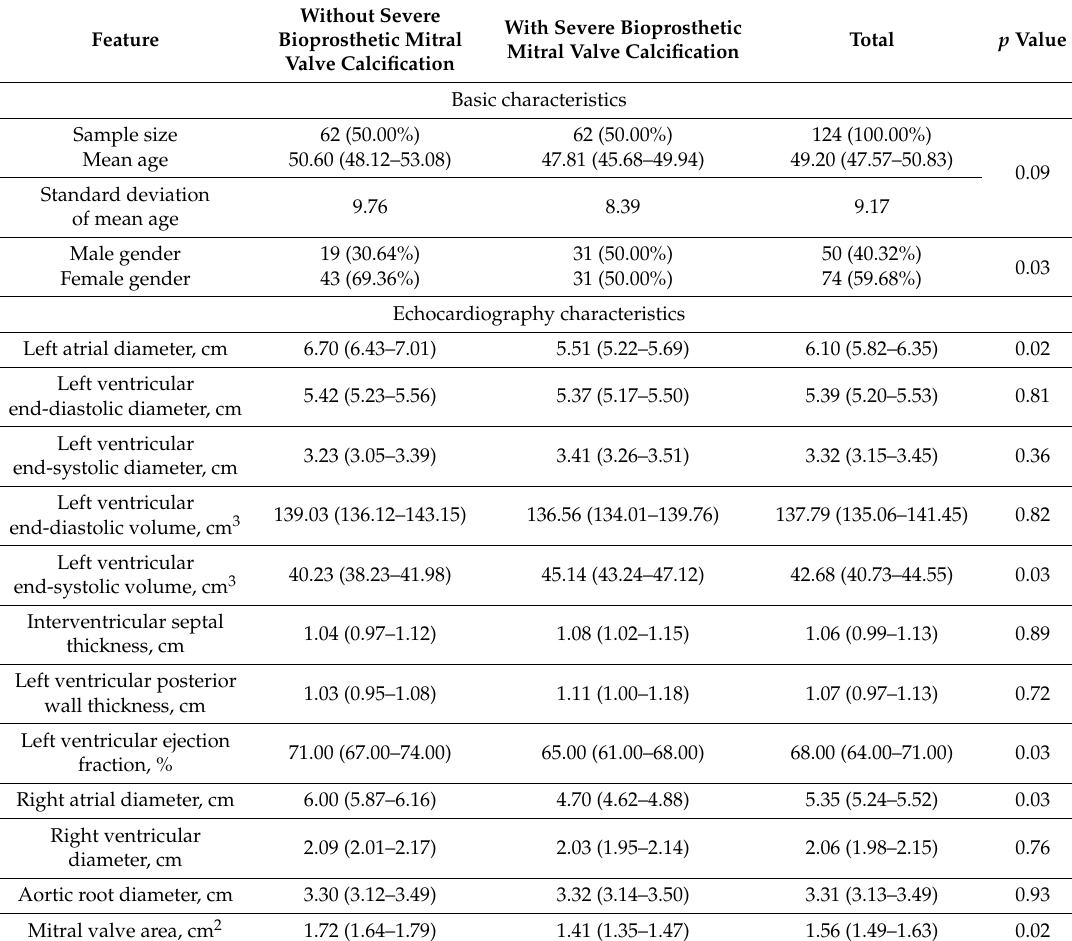
Table 4. Basic and echocardiography characteristics of the study